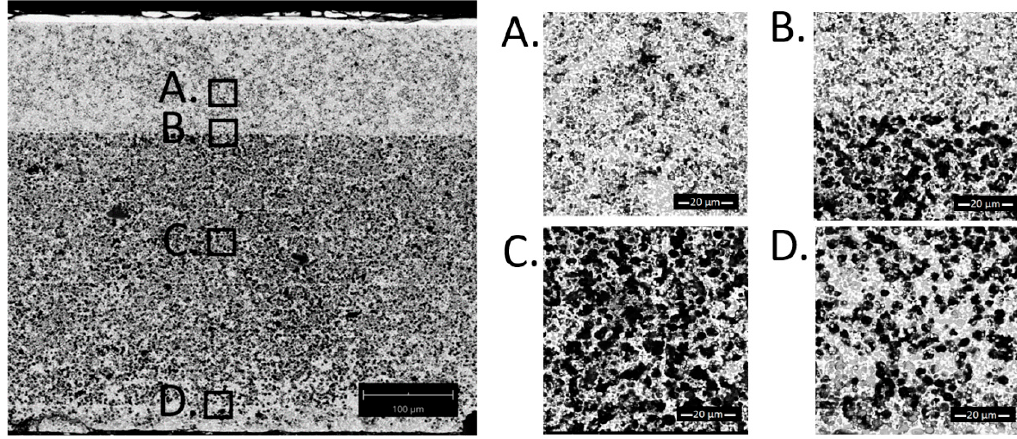
Figure 5. SEM cross-section images of a sample with 34 vol.% NiO obtained using the “standard” method. ( A ) is the region of the functional layer, ( B ) is the interface between the functional and the